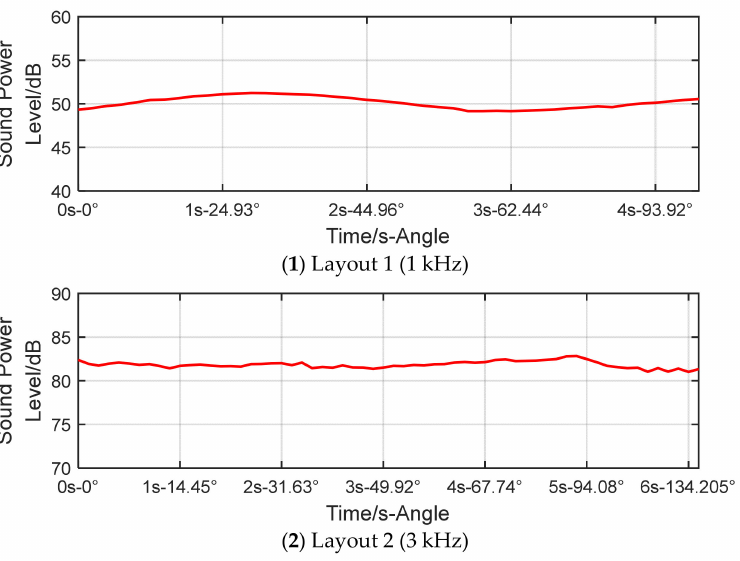
Figure 11. Calculated sound power level versus